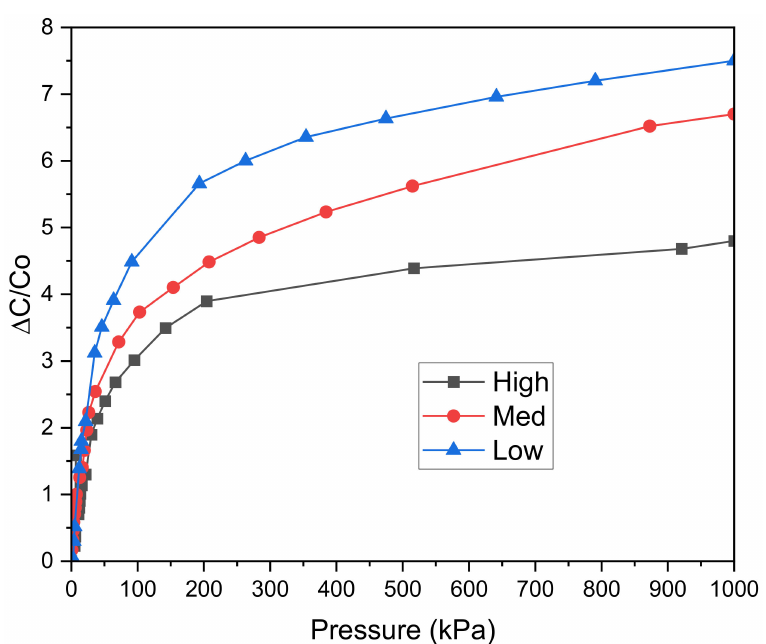
Figure 9. Pressure-response curves of capacitive pressure sensors with different